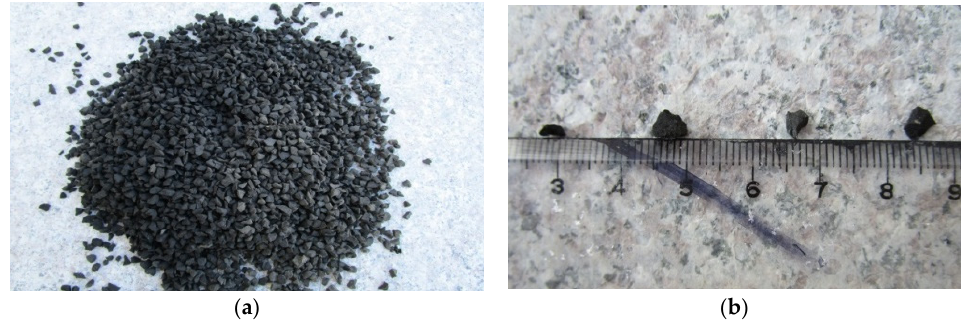
Fig ure 2. Crumb rubber with a size of 2–4 mm. ( a ) Crumb rubber; ( b ) particle size.